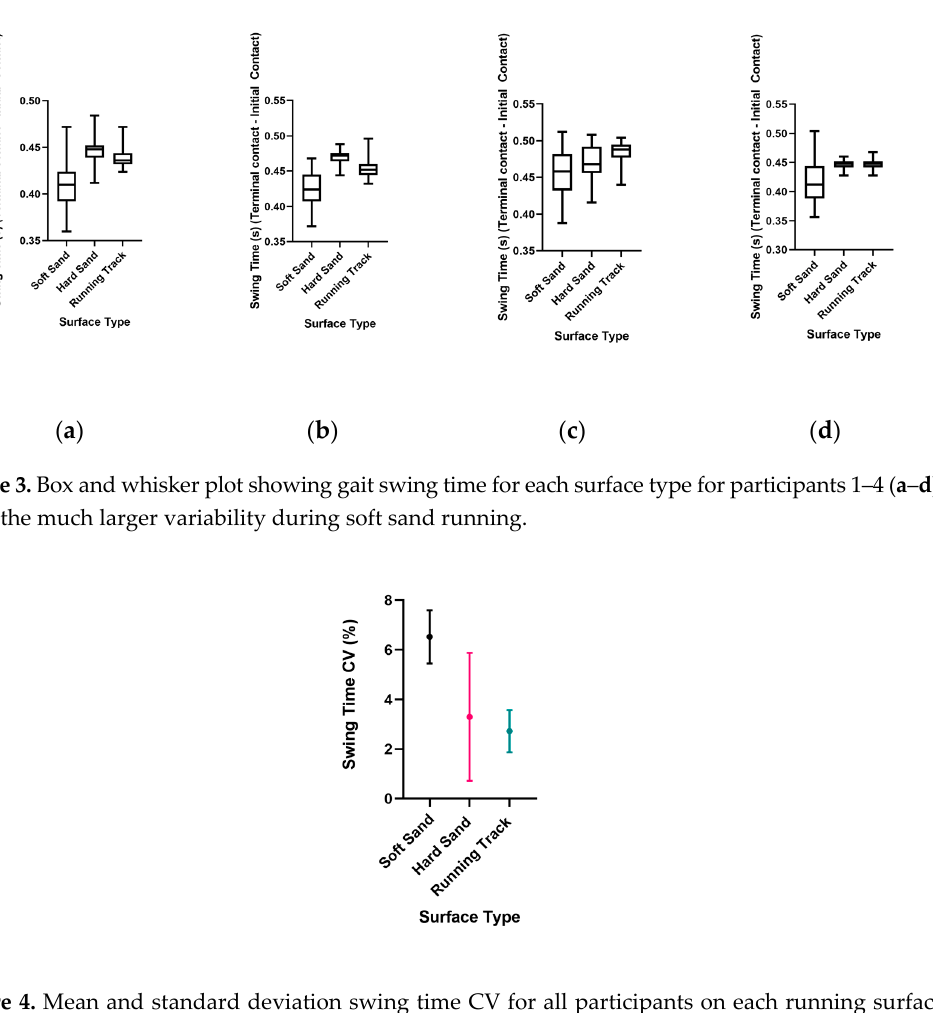
Figure 4. Mean and standard deviation swing time CV for all participants on each running surface (6.5 ± 1.1), (3.3 ± 2.6), (2.7 ±